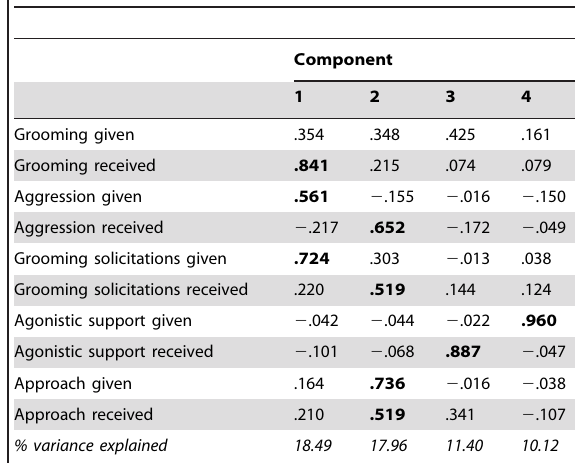
Table 3. Varimax rotated component matrix of the principal component analysis run on the ten variables measuring relationship quality (using scores per